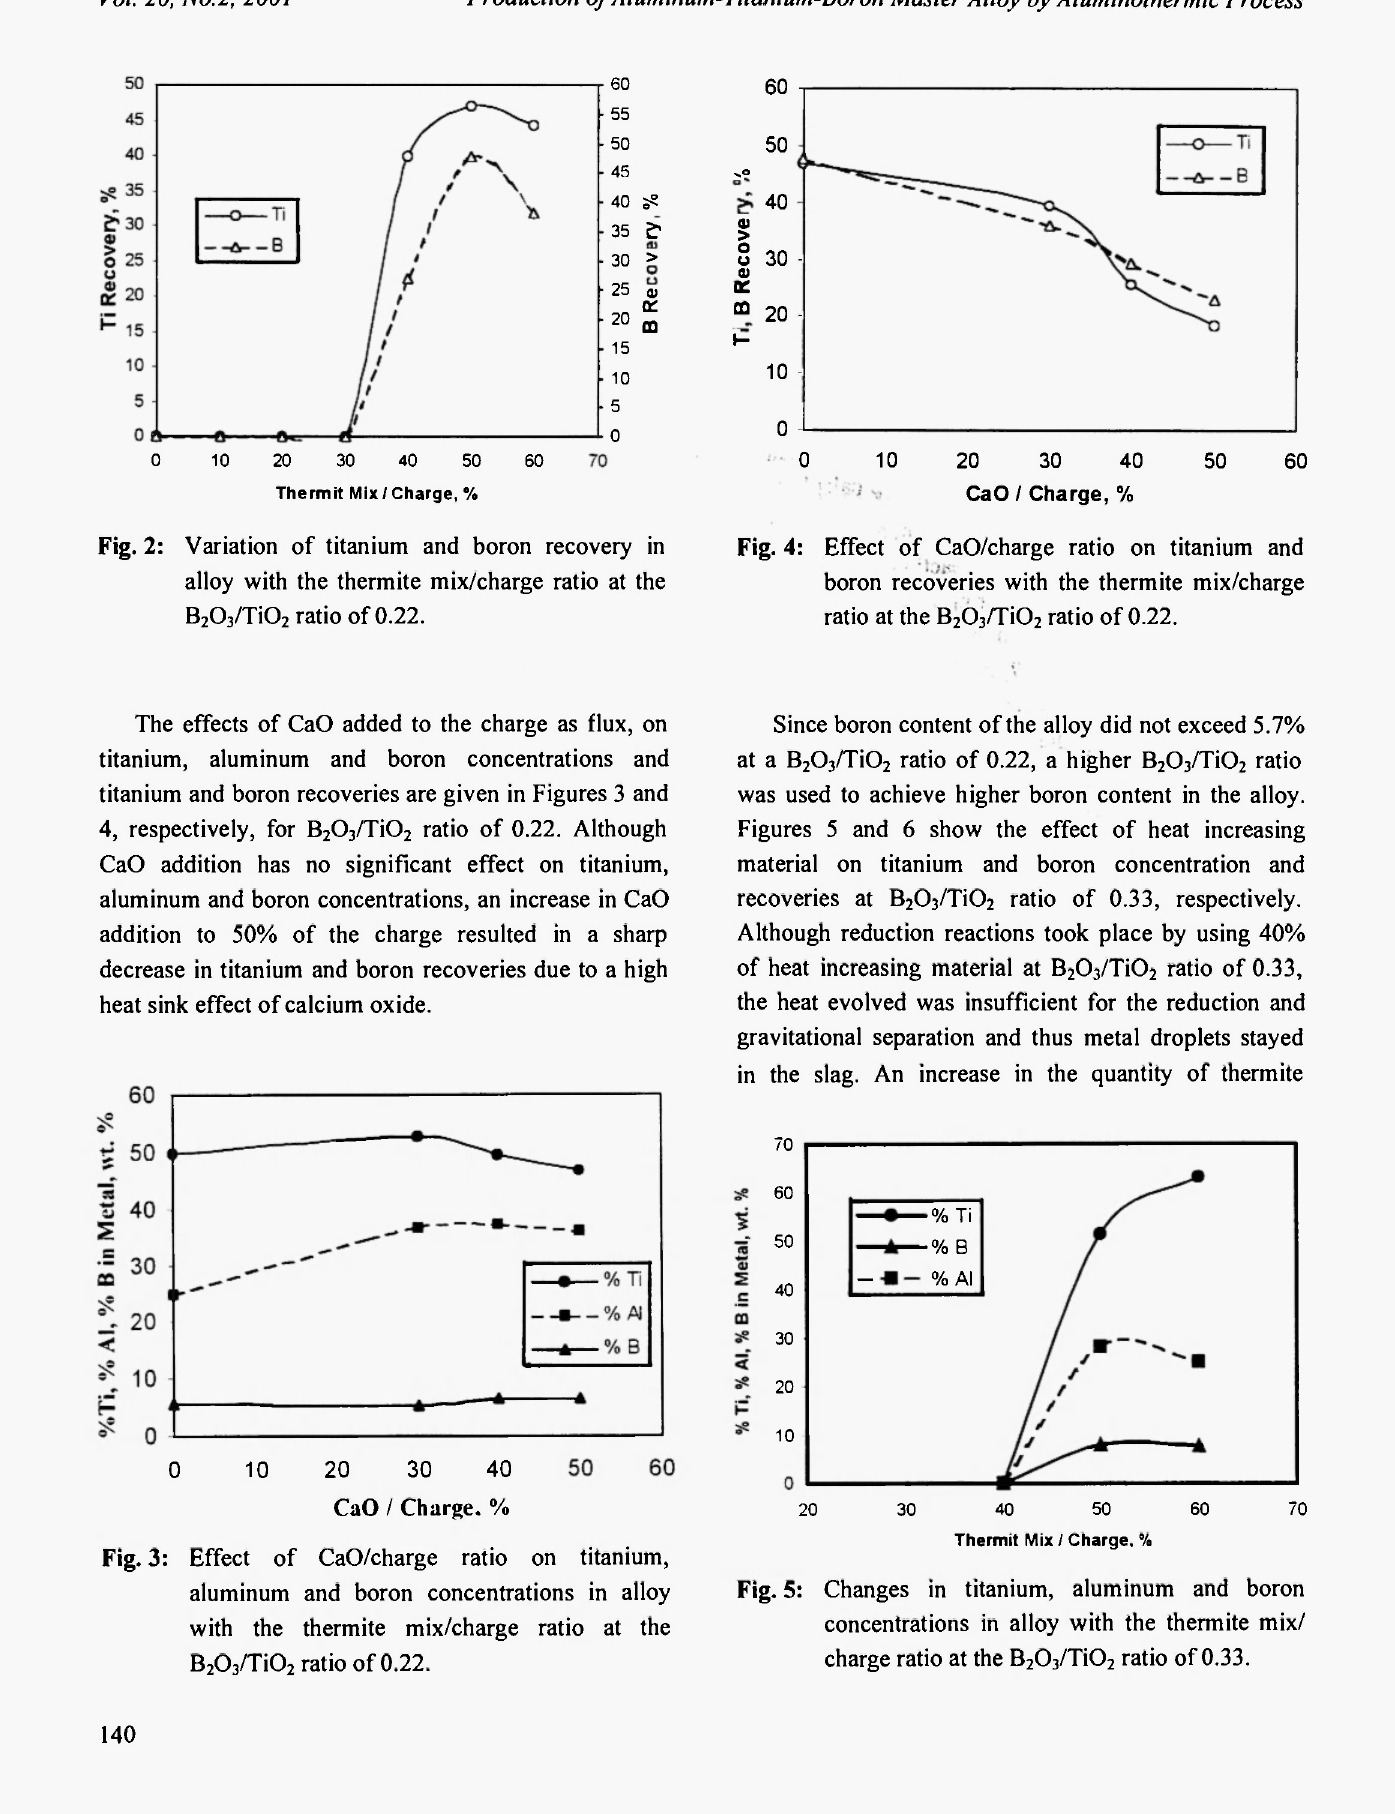
Fig. 3: Effect of CaO/charge ratio on titanium, aluminum and boron concentrations in alloy with the thermite mix/charge ratio at the B 2 0 3 /Ti0 2 ratio of 0.22.